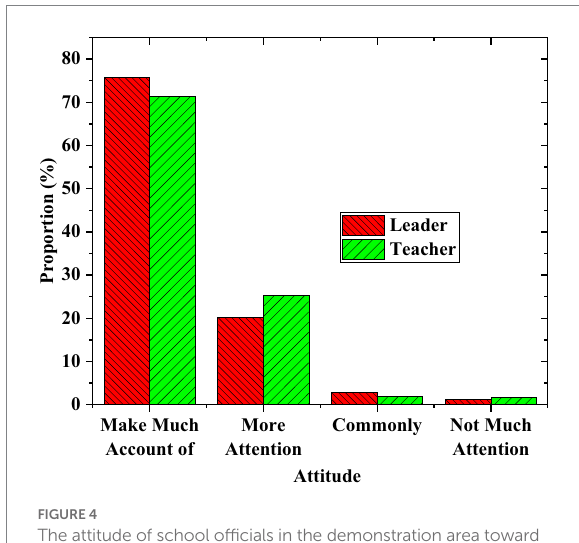
FIGURE 4 The attitude of school officials in the demonstration area toward Olympic education.